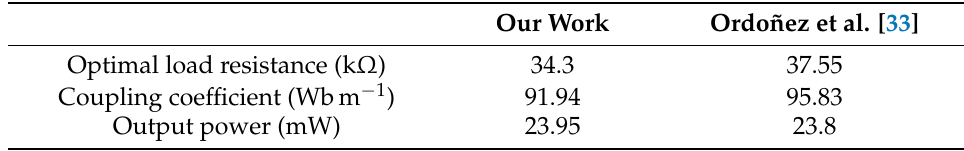
Figure 8. The relationship between the flux linkage and the displacement for the H3M1C configura- tion with parameters listed in Table 4. Table 5. Verification results of the non-optimized H3M1C configuration with previously reported results according to